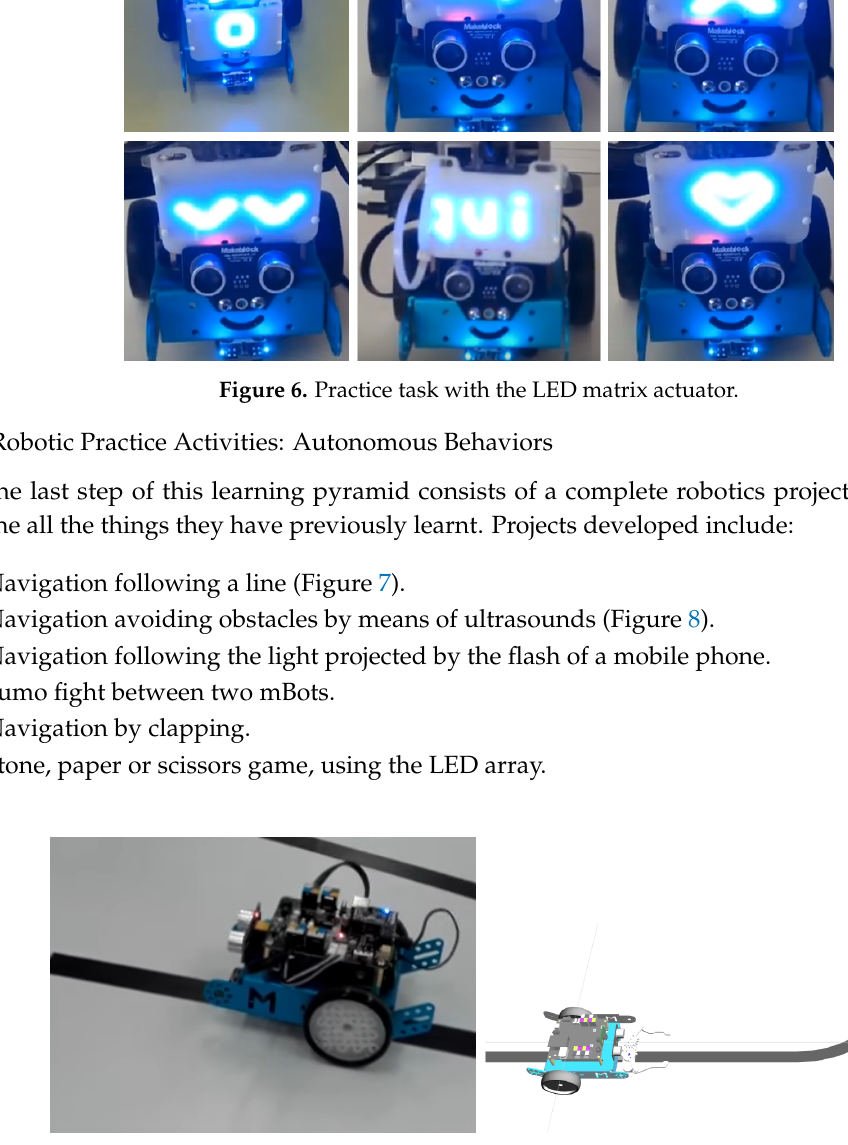
Figure 7. Practice line-tracking task in a real and simulated mBot